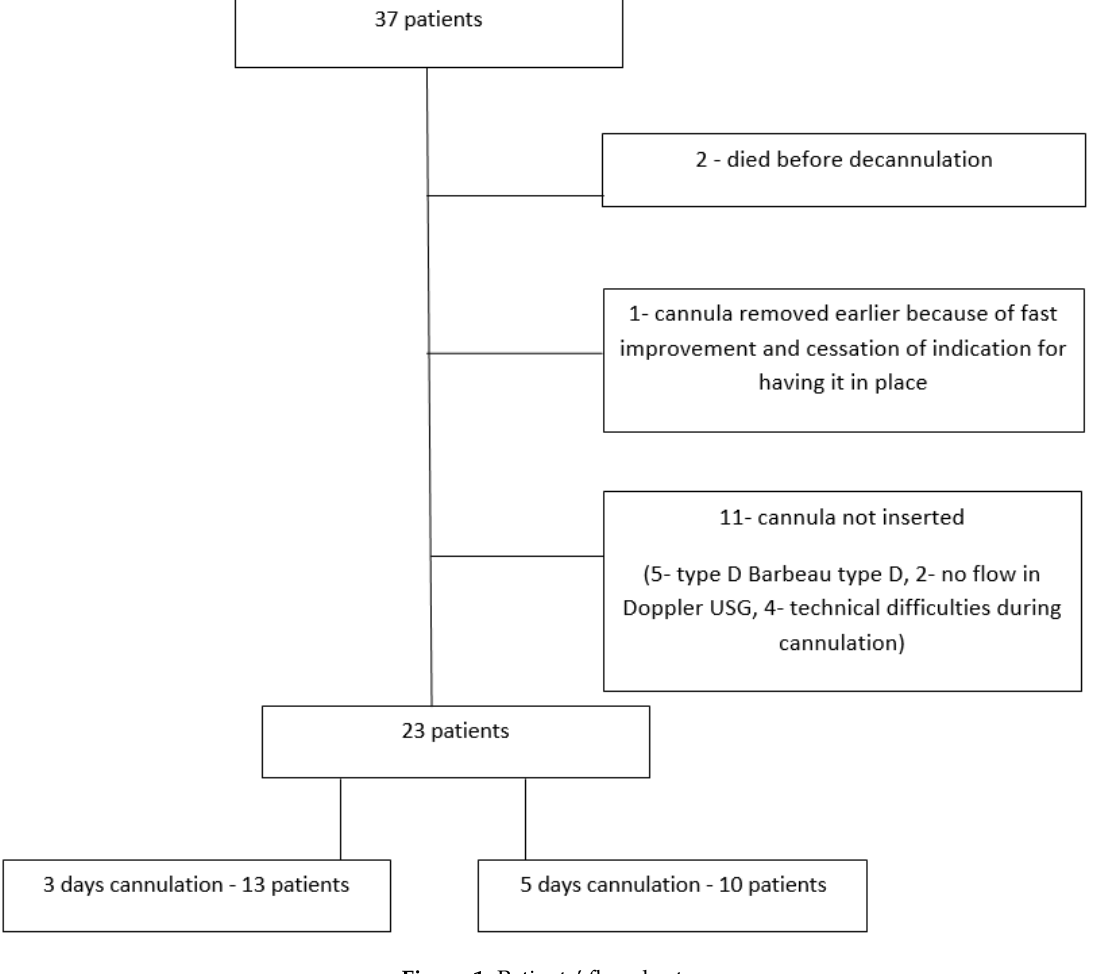
Figure 1. Patients’ flowchart.